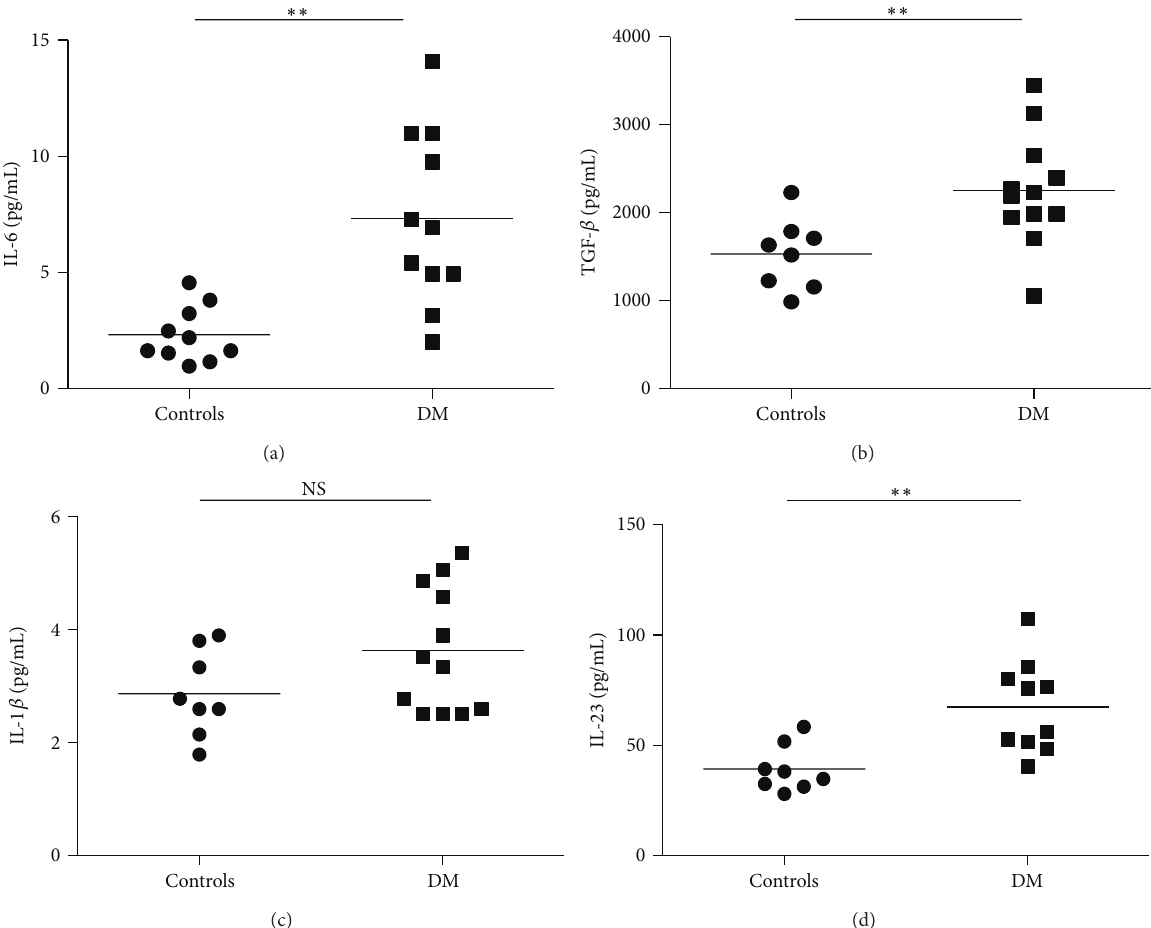
Figure 3: Serum levels of proinflammatory cytokines are increased in DM patients compared with healthy controls. (a) Serum levels of IL-6 were determined by ELISA in serum samples from DM patients and controls. (b) Serum levels of IL- 1𝛽 were determined by ELISA in serum samples from DM patients and controls. (c) Serum levels of TGF- 𝛽 were determined by ELISA in serum samples from DM patients and controls. (d) Serum levels of IL-23 were determined by ELISA in serum samples from DM patients and controls. Horizontal lines show the mean. ∗∗ 𝑃 < 0.01 ; ns: no significant